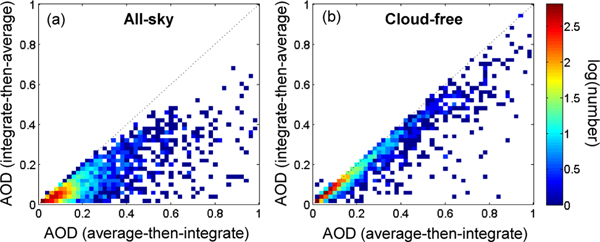
Level 3 mean AOD for all latitude–longitude grid cells in July 2007 at night for (a) all-sky and (b) cloud-free sky conditions. Colors represent the number of grid cells on a logarithmic scale.